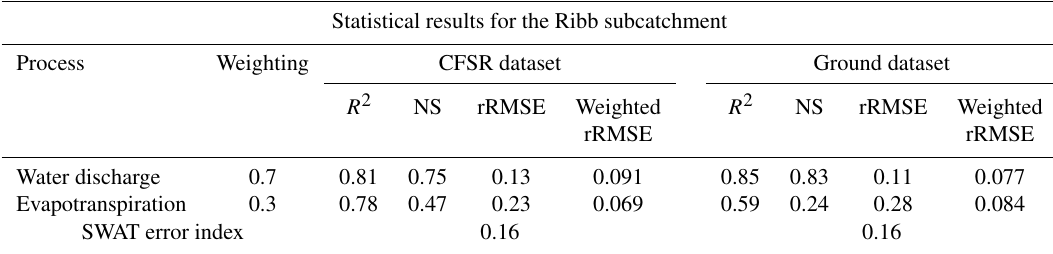
Table 6. Statistical results for the Ribb subcatchment in the Lake Tana region of the upper Blue Nile